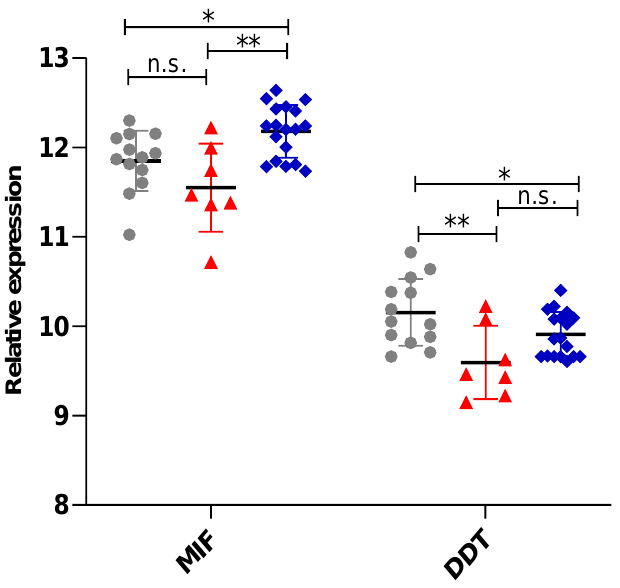
Figure 5. Relative expression analysis of MIF and DDT in DLE samples. Determination of the expression levels of MIF and DDT was performed by interrogating the GSE52471 microarray dataset, retrieved from the Gene Expression Omnibus databank (GEO; https://www.ncbi.nlm.nih.gov/gds). The GSE52471 dataset included whole genome expression profiles of skin biopsies from seven DLE patients, 13 healthy donors, and 18 psoriatic patients. The LIMMA (Linear Models for Microarray Analysis) R package was used for identifying differentially expressed genes. An adjusted p-value < 0.05 was considered as the threshold of significance.